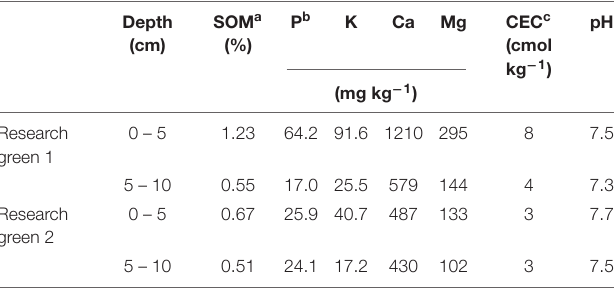
TABLE 1 | Soil chemical properties of two putting green root zones used for creating or evaluating the growth prediction models. Depth